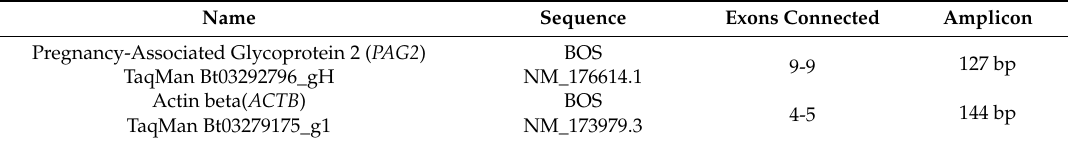
Table 1. TaqMan Gene Expression assays used in the studies are listed by assay numbers. The TaqMan Gene Expression assay is composed of a pair of unlabelled PCR primers and a probe with a FAM dye label on the 5 (cid:48) end, and a minor groove binder (MGB) non-fluorescent quencher (NFQ) on the 3 (cid:48)